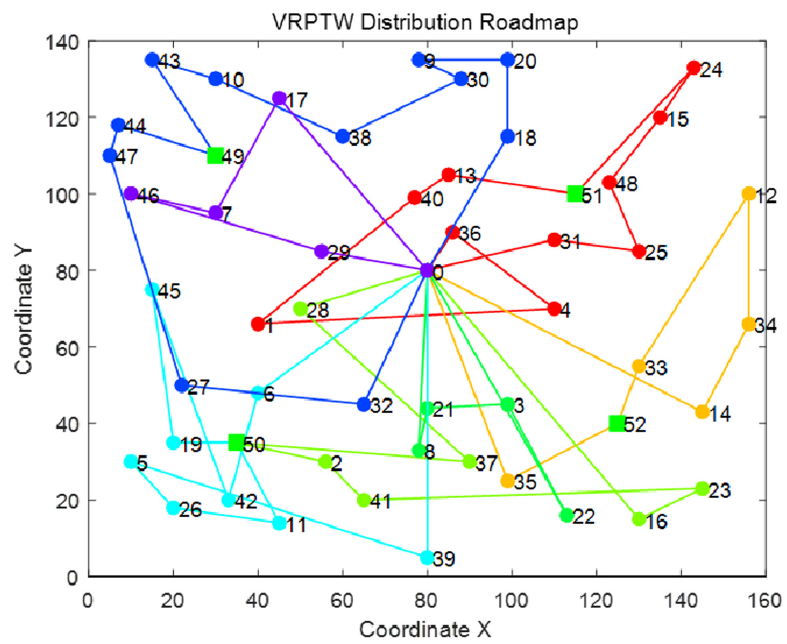
Fig 6. H-NSGA-II optimal path.